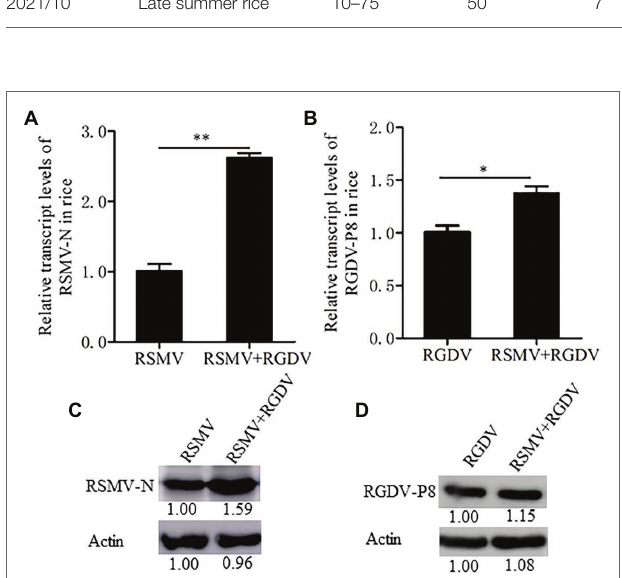
FIGURE 2 | Co-infection with RSMV and RGDV significantly increased the accumulation of RSMV in rice plants. (A) The relative transcript levels of RSMV N were determined by RT-qPCR at 30 dpi in rice plants infected with either RSMV or both RSMV and RGDV. (B) The relative transcript levels of RGDV P8 were determined by RT-qPCR at 30 dpi in rice plants infected with either RGDV or both RSMV and RGDV. Means (±SD) from three biological replicates are presented. * p < .05 and ** p < .01. (C,D) The protein accumulation levels of RSMV N (C) or RGDV P8 (D) in rice plants